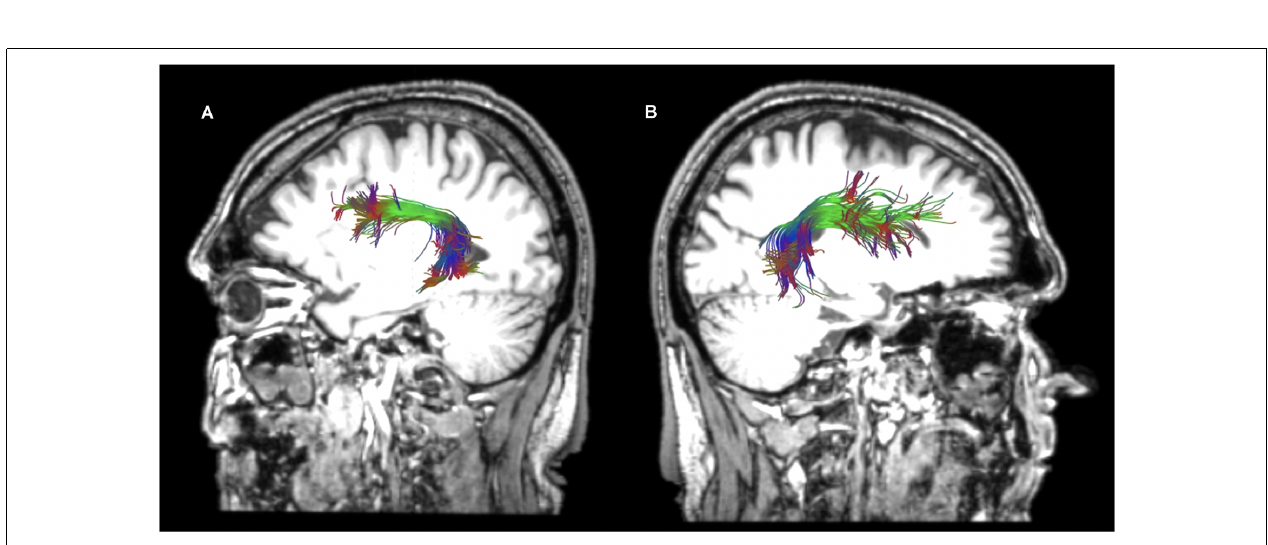
FIGURE 4 | Sagittal views of the reconstructed arcuate fasciculus (AF) in the left (A) and right (B) hemispheres of a healthy participant in native